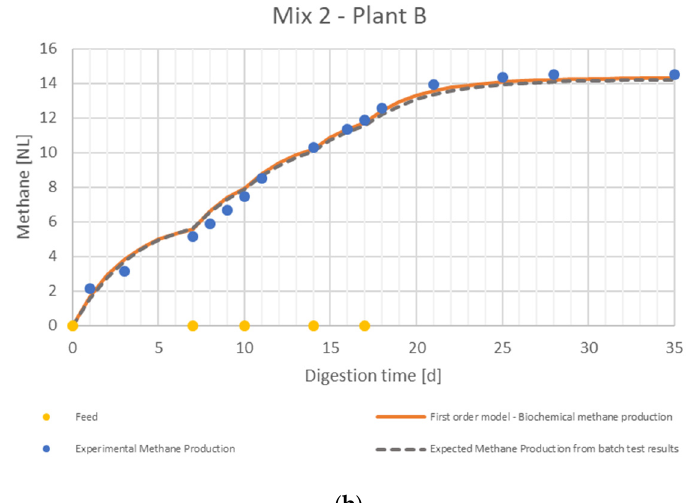
Figure 2. AD fed ‐ batch tests. Measured points, simulated biochemical methane production curves, and expected biochemical methane production curves (validation of batch test results). ( a ) mix 1; ( b ) mix 2. Table 5. Results of batch anaerobic digestion tests performed on a single matrix and mixed matrices.